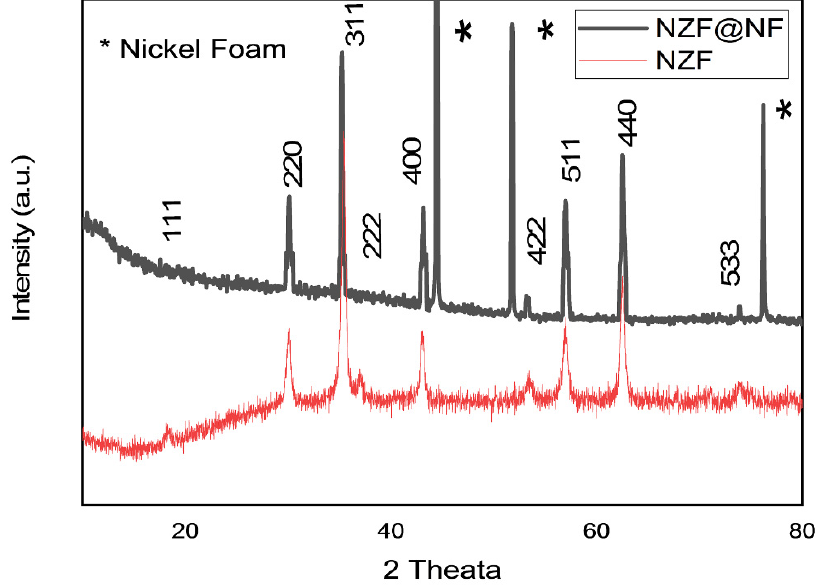
Figure 1. X-ray diffraction of NZF and NZF@NF.